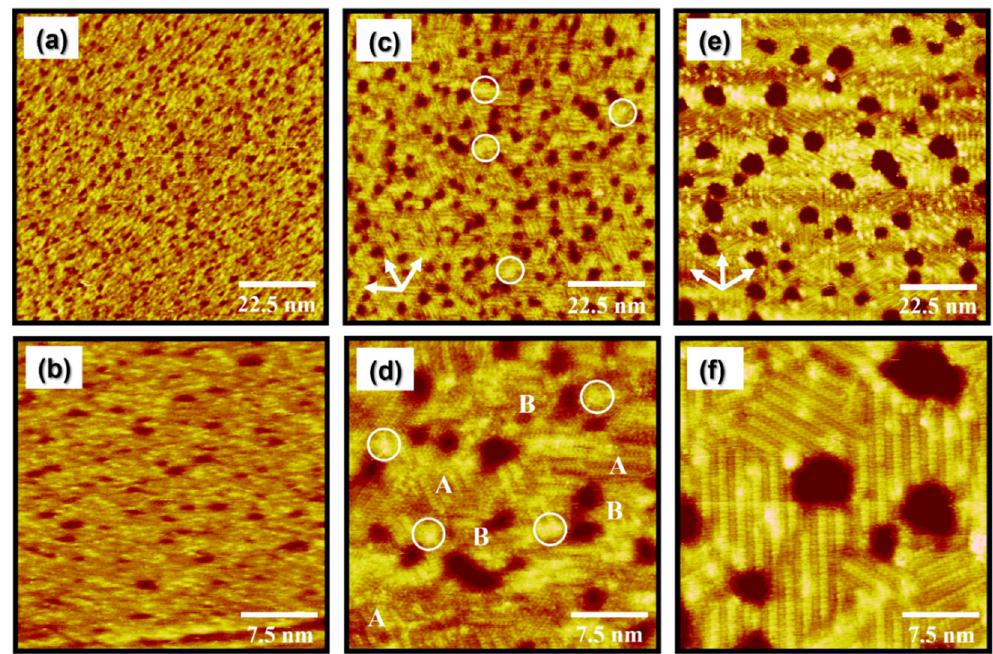
Figure 2. STM images of EG2 SAMs on Au(111) formed over 24 h at a vapor deposition temperature of ( a , b ) 298 K, ( c , d ) 323 K, and ( e , f ) 348 K. Scan sizes of STM images are 90 × 90 nm 2 ( a , c , e ) and 30 × 30 nm 2 ( b , d , f ). Note that A and B in Figure 2d correspond to the ordered domains and the disordered domains, respectively.